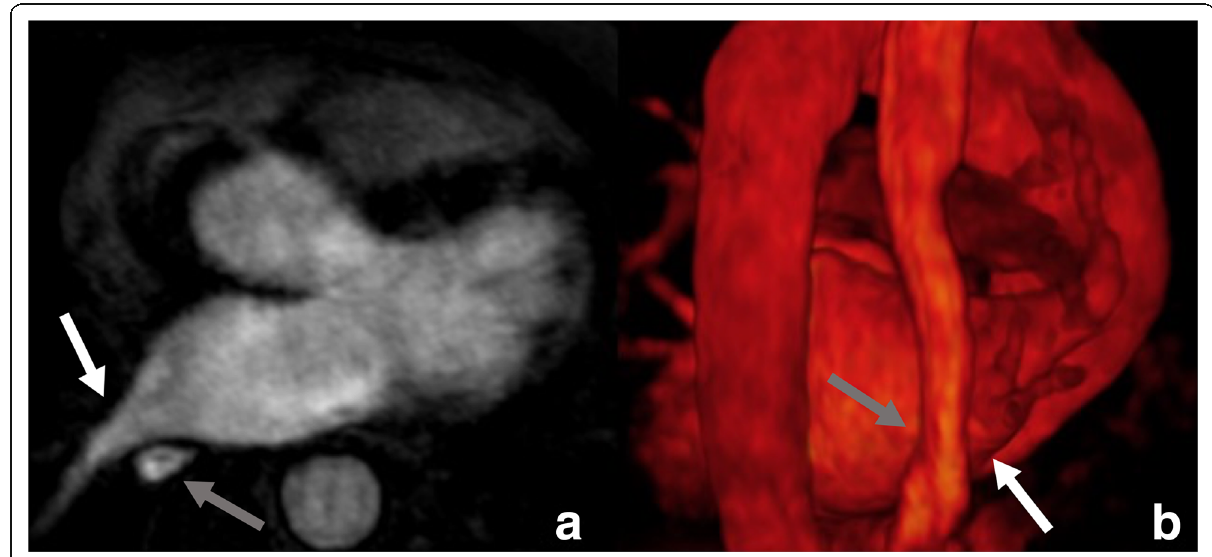
Fig. 4 Axial images ( a ) with the corresponding 3D volume rendering ( b ) of the MRA. Note how the oesophagus ( grey arrow ) courses near the ostia of the right inferior pulmonary vein ( white arrow